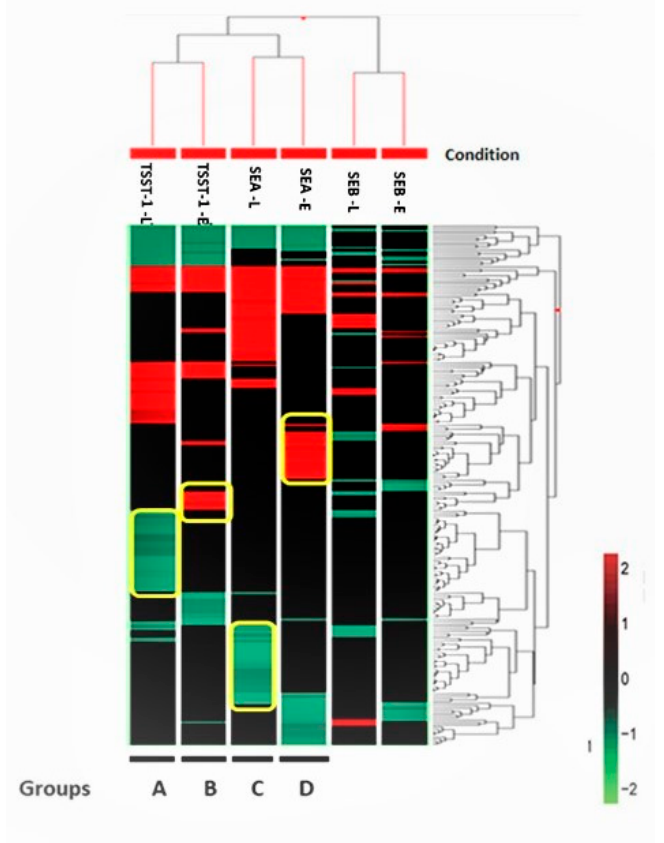
Figure 2. Hierarchical clustering analysis using of 217 genes with a log 2 fold change > |2| enriching the necrosis pathway. The Euclidian algorithm was used to sort both conditions and genes. Each block represents one gene, and its color code is at the bottom right. Clusters bordered by yellow lines represent those genes which were potentially unique signatures of the particular condition. The conditions from left to right are named as TSST-1-L, TSST-1-E, SEA-L, SEA-E, SEB-L, and SEB-E, which represent TSST-1 at the late time point, TSST-1 at the early time point, SEA at the late time point, SEA at the early time point, SEB at the late time point, and SEB at the early time point, respectively.